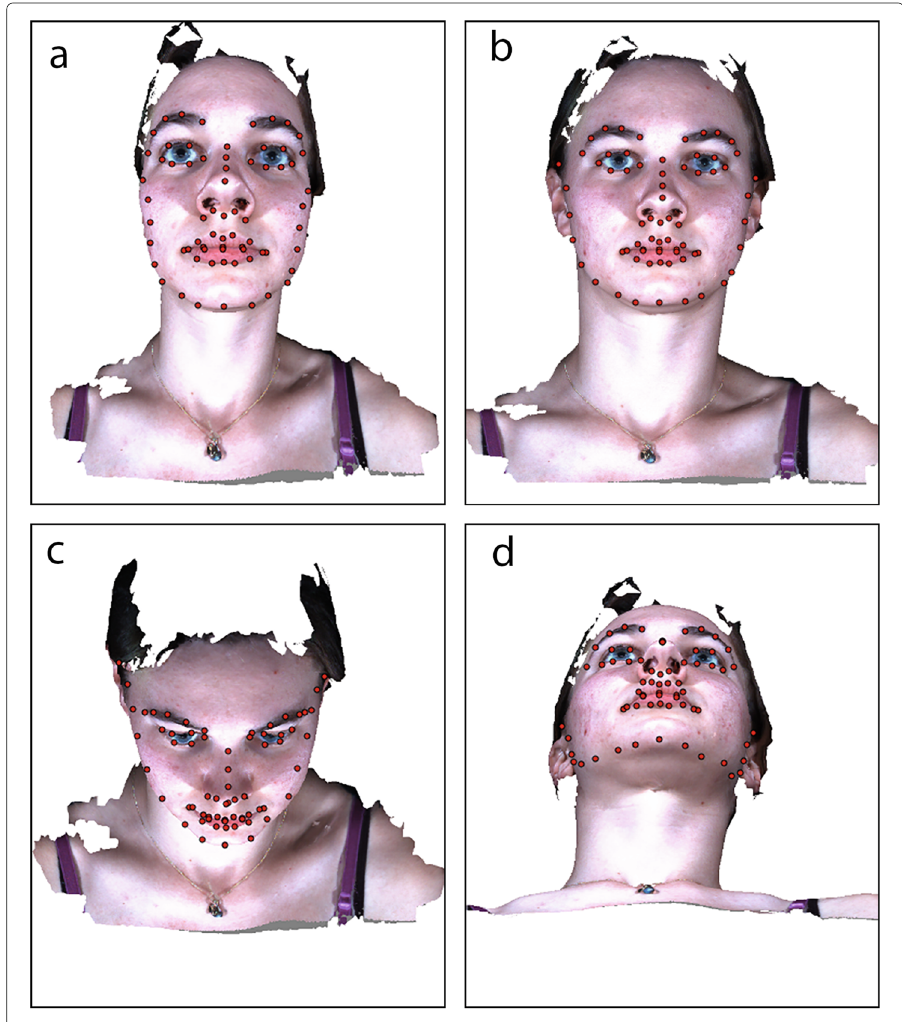
Fig. 7 Converted 2D ground-truth on images. a and b are ground-truth landmarks with 24 mm and 135 mm focal length at the center view, respectively. c and d are rendered landmarks from top view and down view with 135 mm focal